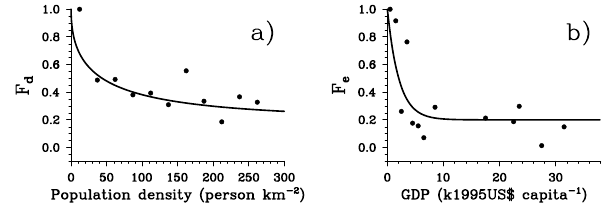
Fig. 6. Effects of (a) demographic situation F d and (b) eco- nomic situations F e on average burned area of a fire (lines). In shrub- and grass-dominated regions, we partition average burned area of a fire (derived from 2001–2004 GFED3 burned area and MODIS fire counts at 0.5 ◦ spatial resolution) divided by F e (i.e., a MODIS , GFED3 /F e ) over 25personkm − 2 population den- sity bins, and average burned area per fire divided by F d (i.e., a MODIS , GFED3 /F d ) over 1k1995US$capita − 1 GDP bins. Black circles indicate the (normalized) average in bins with sample size > 5. Goodness of fit is R 2 = 0 . 71 ( n = 13) in (a) and R 2 = 0 . 81 ( n = 11) in (b) .